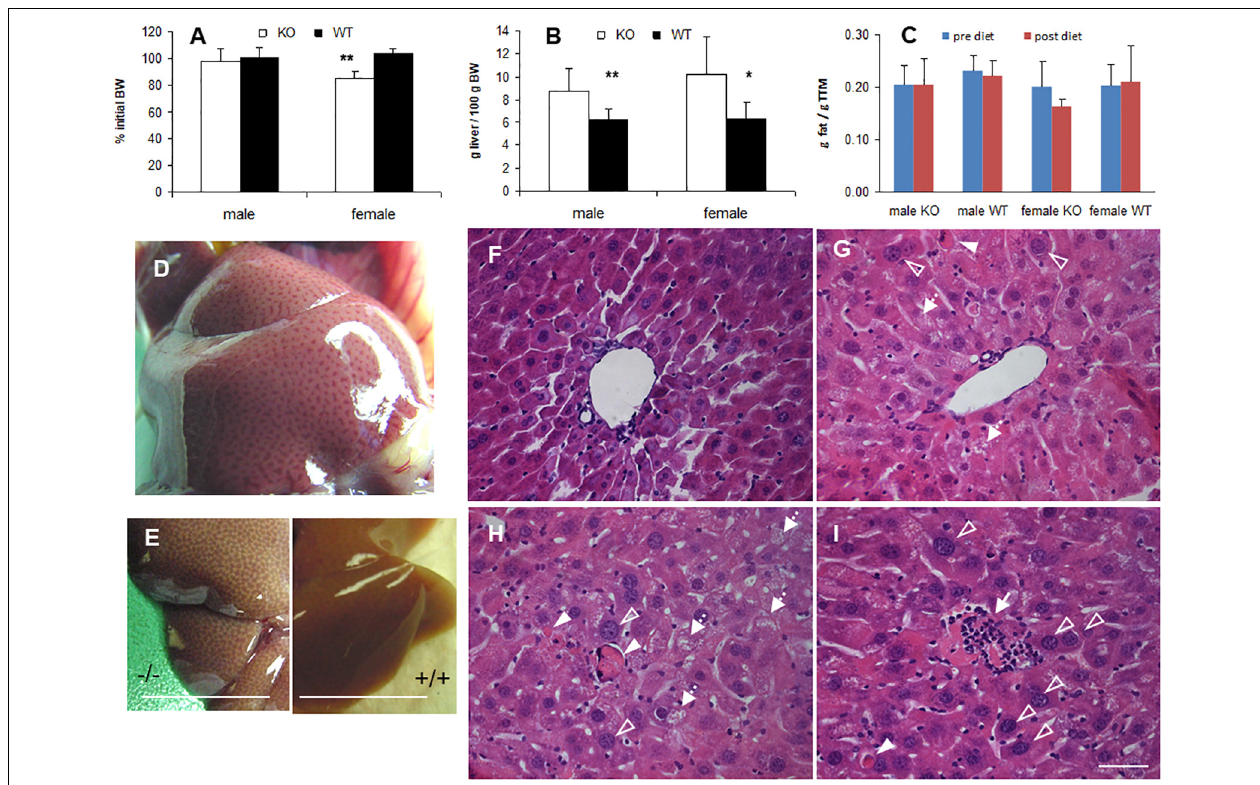
FIGURE 3 | Phenotype of phytol challenged PMP34 knockout mice. (A–C) Influence of phytol diet on male or female PMP34 knock out (KO) mice versus age matched wild type (WT) mice on body weight, expressed as % of body weight (BW) at the start of the diet (A) , liver size, expressed in g/100 g BW (B) , and fat mass, expressed in g/g total tissue mass (TTM) as determined by DEXA at the start and end of the diet (C) . Data are represented as mean ± SD ( n = 4-8 (A,B) or 3-6 (C) per gender and per genotype. The effect of phytol was statistically analyzed per gender (Oneway ANOVA ** P < 0.01, * P < 0.05 KO versus WT). Heterozygous mice responded in a similar way to phytol diet as WT animals and liver size and fat mass of KO and WT did not differ on a control diet (data not shown). (D,E) Mottled appearance of liver of knockout mice on a phytol diet, as seen upon dissection of a male mouse (D) or after bleeding and removal of the liver ( E ; scale bar 1 cm). Similar mottling is evident in female KO mice (not shown). (F–I) H&E stained liver sections of WT (F) and KO male mice (G–I) on phytol enriched diet showing enlarged nuclei (open arrowhead), apoptotic bodies (full arrowhead), inflammation zones (arrow) and microvesicular steatosis (dashed arrow) in the phytol-fed